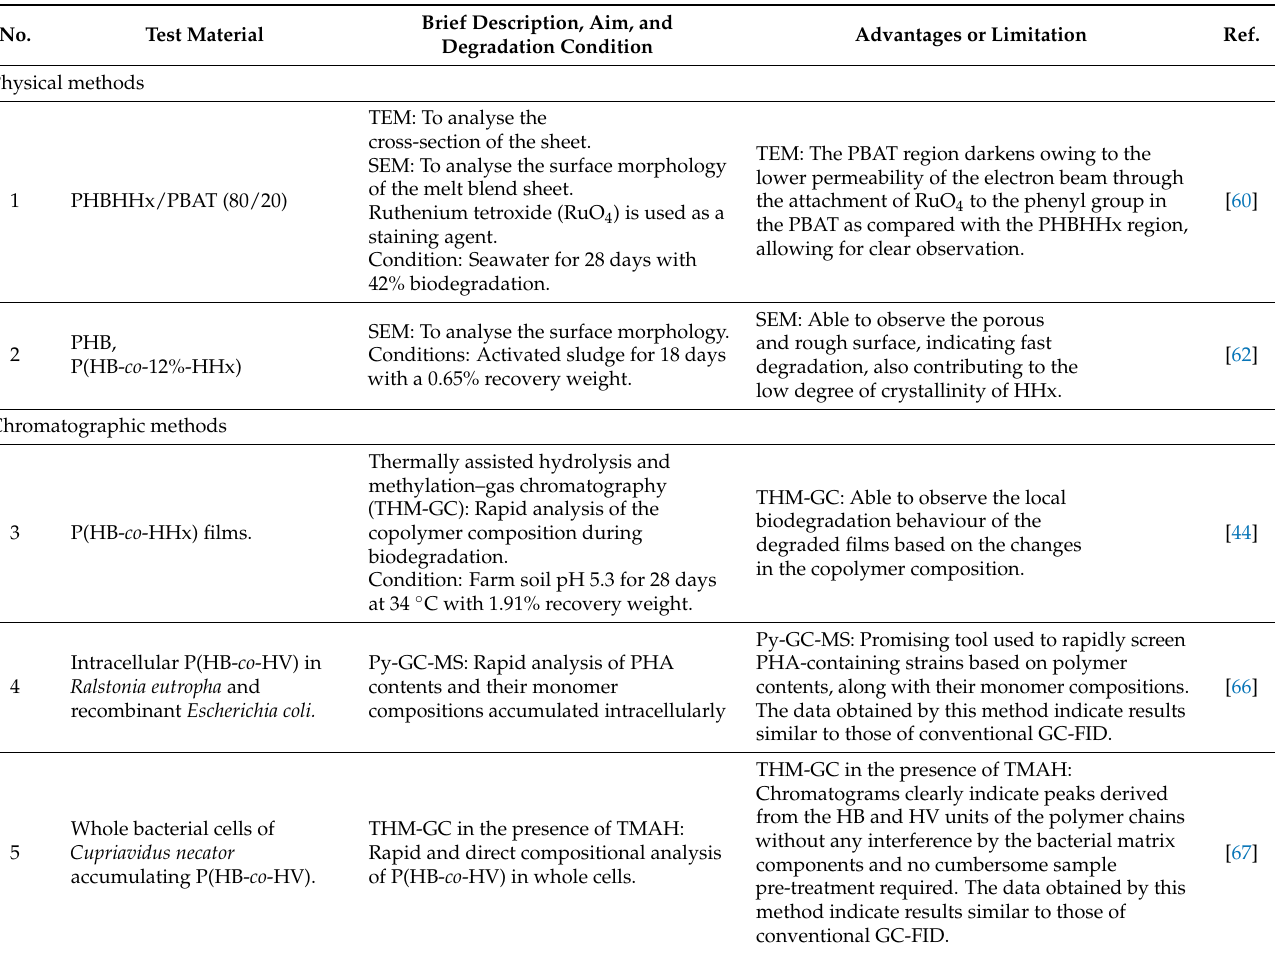
Table 2. Summarization of numerous methods to assess the biodegradation of polymers in various experimental settings, together with their advantages and